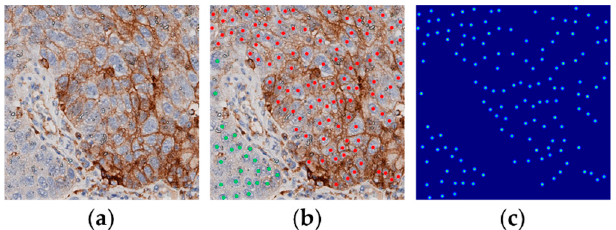
Figure 1. ( a ) An example of PD-L1 slides from the LUSC data set, ( b ) dot annotations (red indicates positive viable tumour cells and green negative ones) and ( c ) distance map generated from the dot annotations.